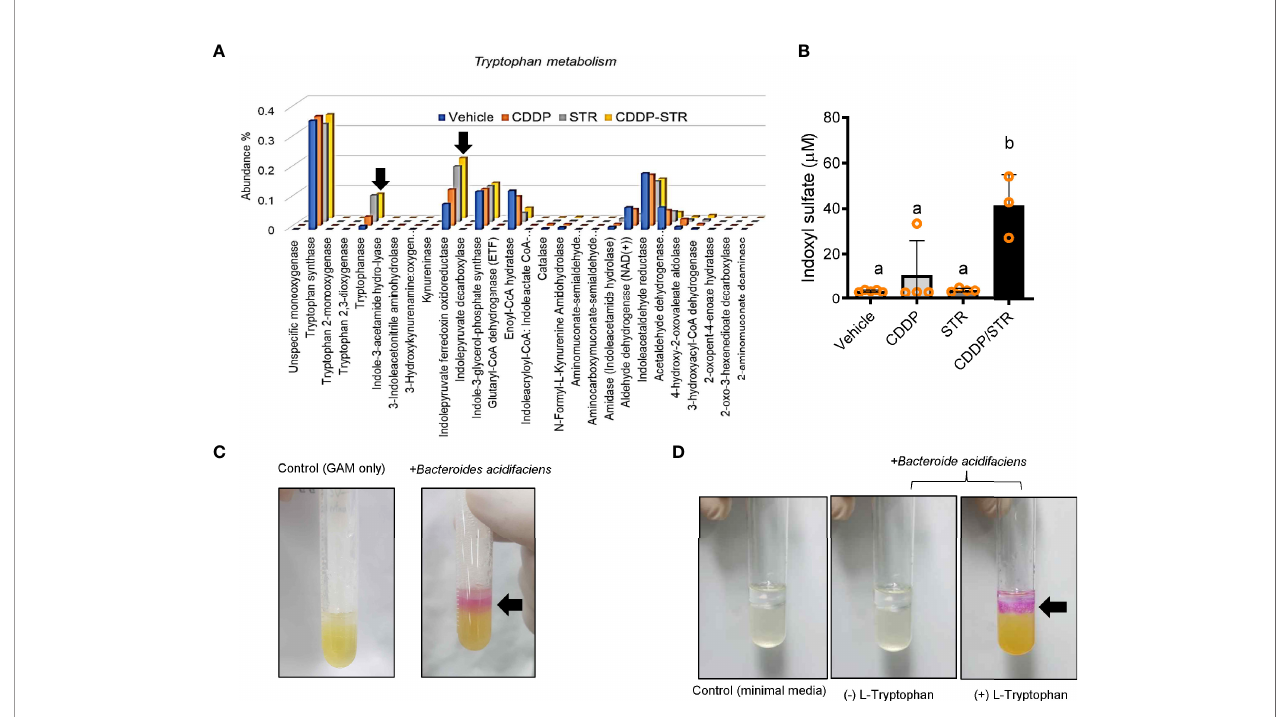
FIGURE 6 | Effects of STR exposure on the bacterial tryptophan metabolism in CDDP-induced renal injury model. Eight-week-old wild type male mice (n = 3 – 5) were orally preexposed to the vehicle or streptomycin (20 mg/mouse) for 24 h and then renal injury was induced with CDDP (20 mg/kg) via intraperitoneal administration for an additional 72 h. The fecal bacteria were subjected to 16S rRNA analysis for the determination of the phylogenetic composition. (A) Genes related to tryptophan metabolism reconstructed from 16S rRNA pro fi le-based metagenomic prediction using PICRUSt2 . (B) The blood indoxyl sulfate levels were measured using high-performance liquid chromatography. The different letters represent signi fi cant differences between groups using ANOVA with Newman – Keuls method as a post hoc ANOVA assessment (p<0.05). (C, D) Ehrlich ’ s test for indole production from Bacteroides acidifaciens . The bacteria were cultured in the Gifu anaerobic media (GAM) broth (C) , or minimal media with or without tryptophan (5mg/ml) (D) . Results are representative of three independent